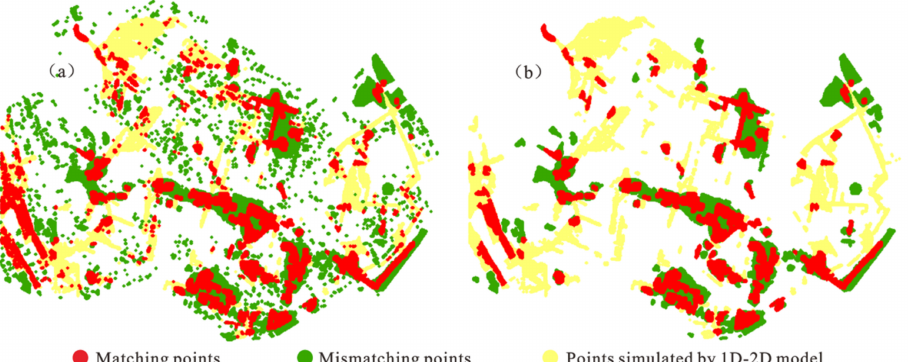
Figure 4. Comparison of the flood-prone areas captured by ( a ) conventional and ( b ) refined DE analyses, respectively. Three types of points are all shown on the 5.0 × 5.0-m resolution and include the matching, mismatching and the flooded points simulated by the baseline